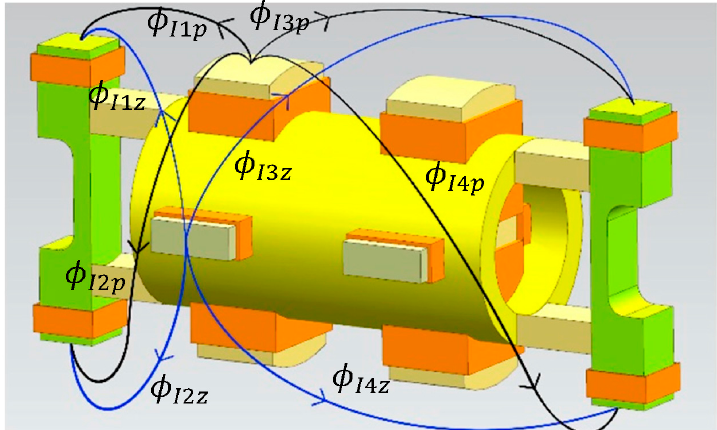
Figure 10. Schematic diagram of magnetic circuit.